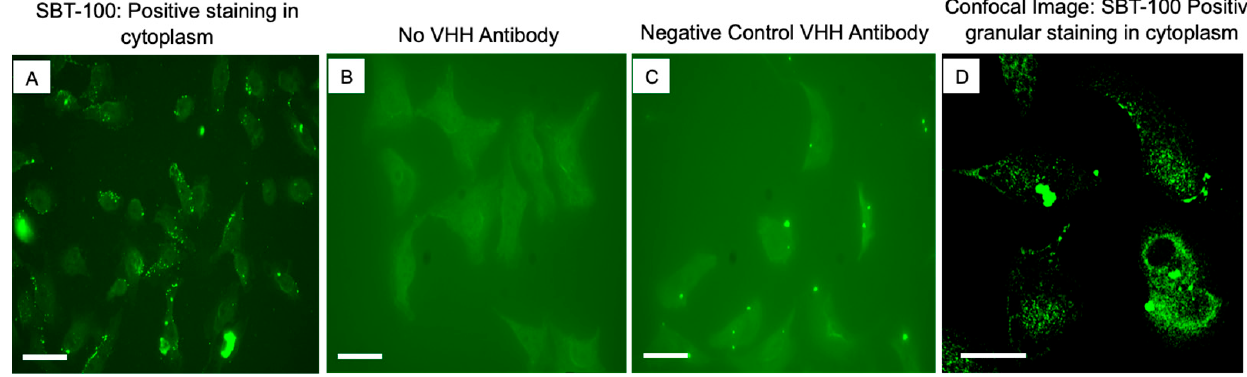
Figure 1. SBT-100 penetrates cell membrane of TNBC cell line, MDA-MD-231. ( A ) Immunofluores- cence staining of MDA-MB-231 cells incubated with SBT-100 antibody showed positive cytoplasmic staining using the anti-His tag antibody in green channel. ( B ) MDA-MB-231 cells with no VHH an- tibody were negative. ( C ) No cytoplasmic positive staining was seen with the negative control irrel- evant VHH antibody (anti-HIV 1-reverse transcriptase VHH) with traditional fluorescence micros- copy. ( D ) Confocal image of SBT-100 detection is shown as granular staining located throughout the cytoplasm. The observed staining of SBT-100 in ( A , D ) is cytosolic and not endocytic. The scale bars in the lower-left corner of each panel represent 100 µm.